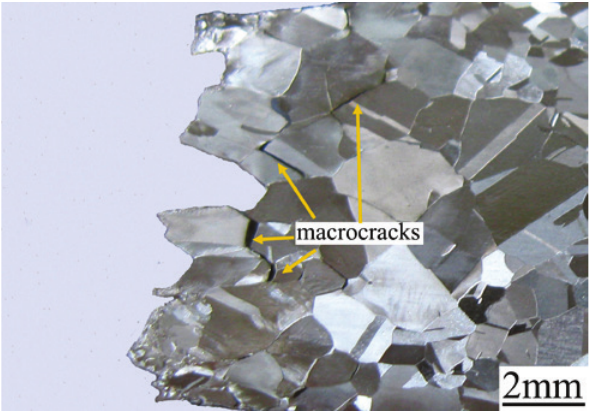
Fig. 6: Macrographs of longitudinal sections close to the fracture of alloy 1 at 900